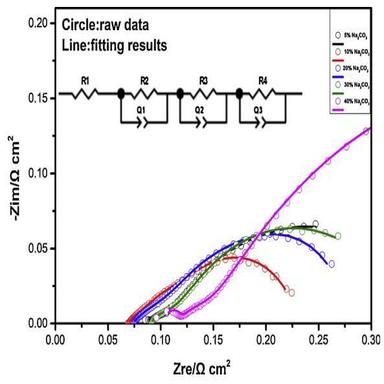
Representative Nyquist plot of single fuel cell assembled from LSCF/ Na2CO3 composite with different carbonate content at 550 °C.